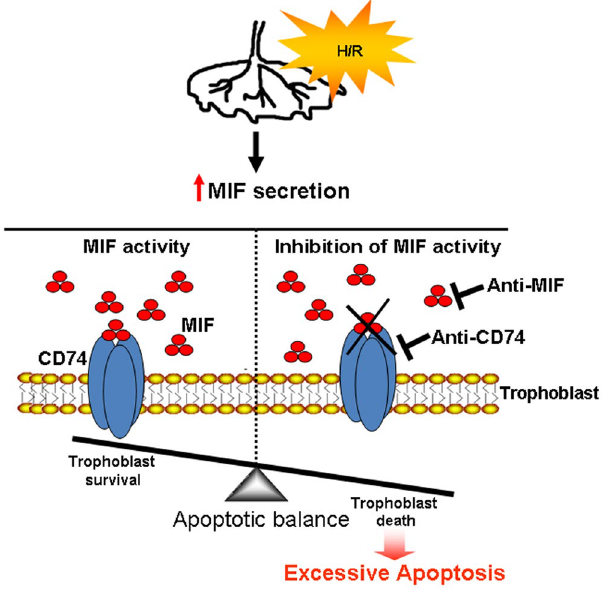
Figure 6. Schematic representation of the role of MIF in the protection of first trimester human placenta against hypoxia/re-oxygenation insults. Upon insults (hypoxia/re-oxygenation, H/R), the placenta increases the release of MIF that, binding to its membrane receptor CD74, protects trophoblast against excessive apoptosis (trophoblast survival). Inhibition of MIF or its binding to CD74 triggers apoptosis (trophoblast